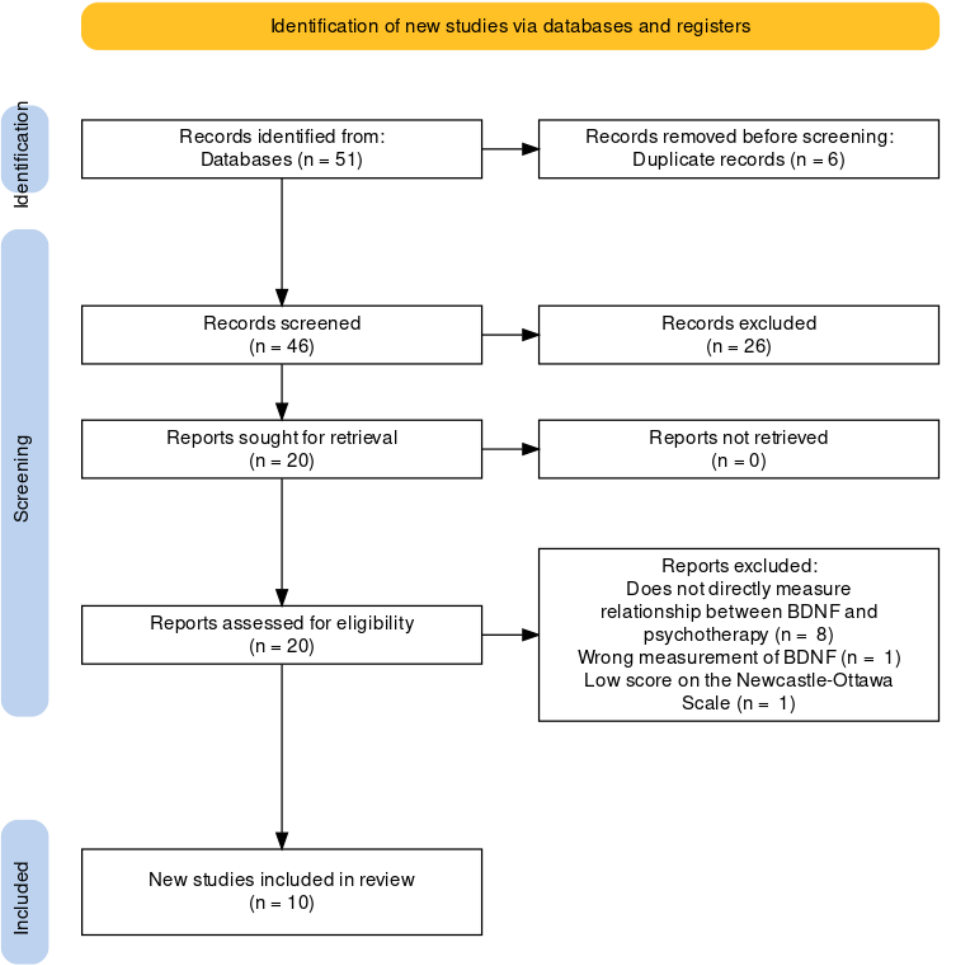
Figure 1. PRISMA flow diagram for the systematic review.